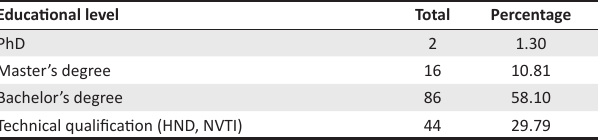
TABLE 1: Educational background of respondents.